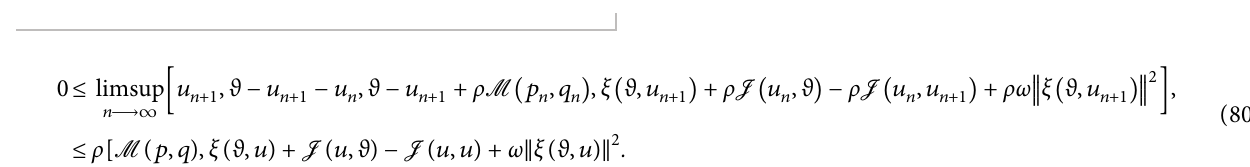
Algorithm 2. At n � 0, start with initial value u